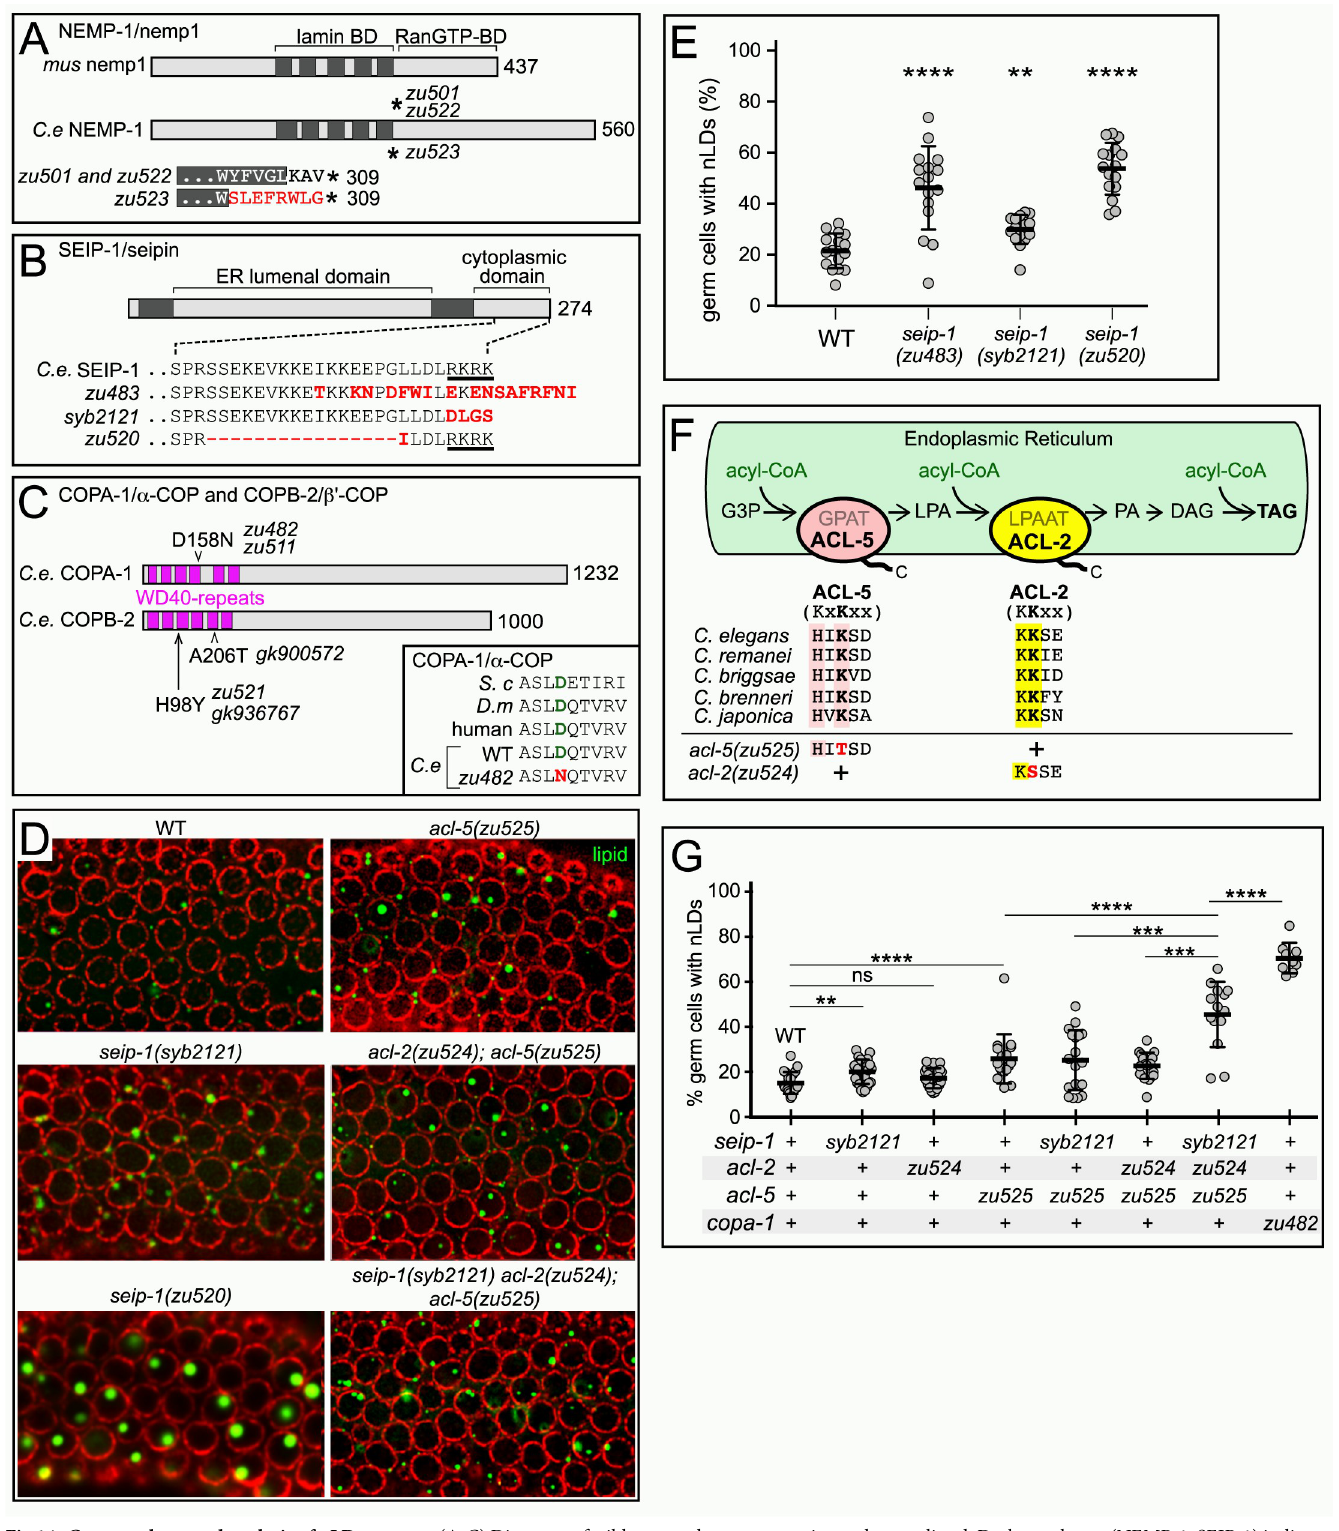
Fig 14. Gene products and analysis of nLD mutants. (A-C) Diagrams of wild-type and mutant protein products as listed. Dark grey boxes (NEMP-1, SEIP-1) indicate transmembrane domains, and protein sizes in amino acids are indicated to the right of each cartoon; amino acid replacements in the mutant proteins are shown in